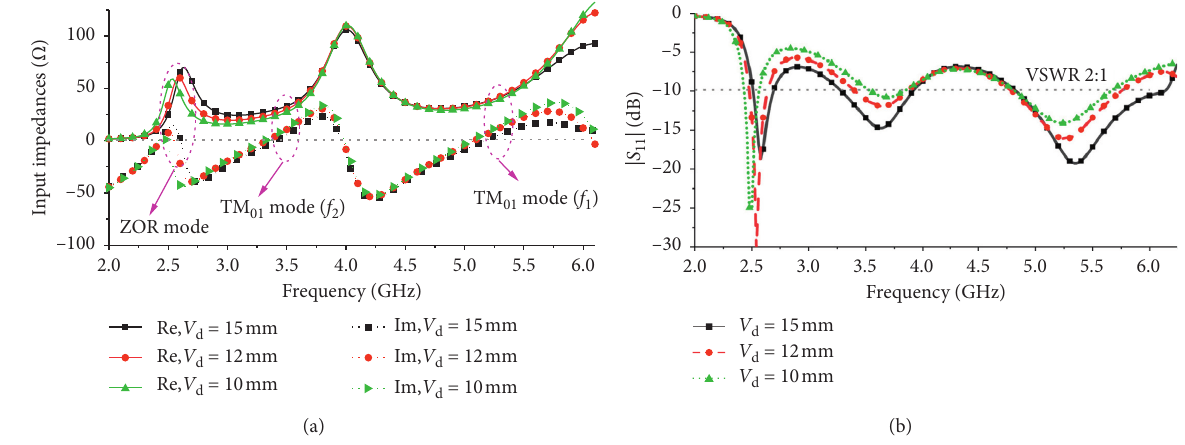
Figure 9: The effect of V d on (a) input impedances and (b) | S 11 | of the proposed patch antenna.